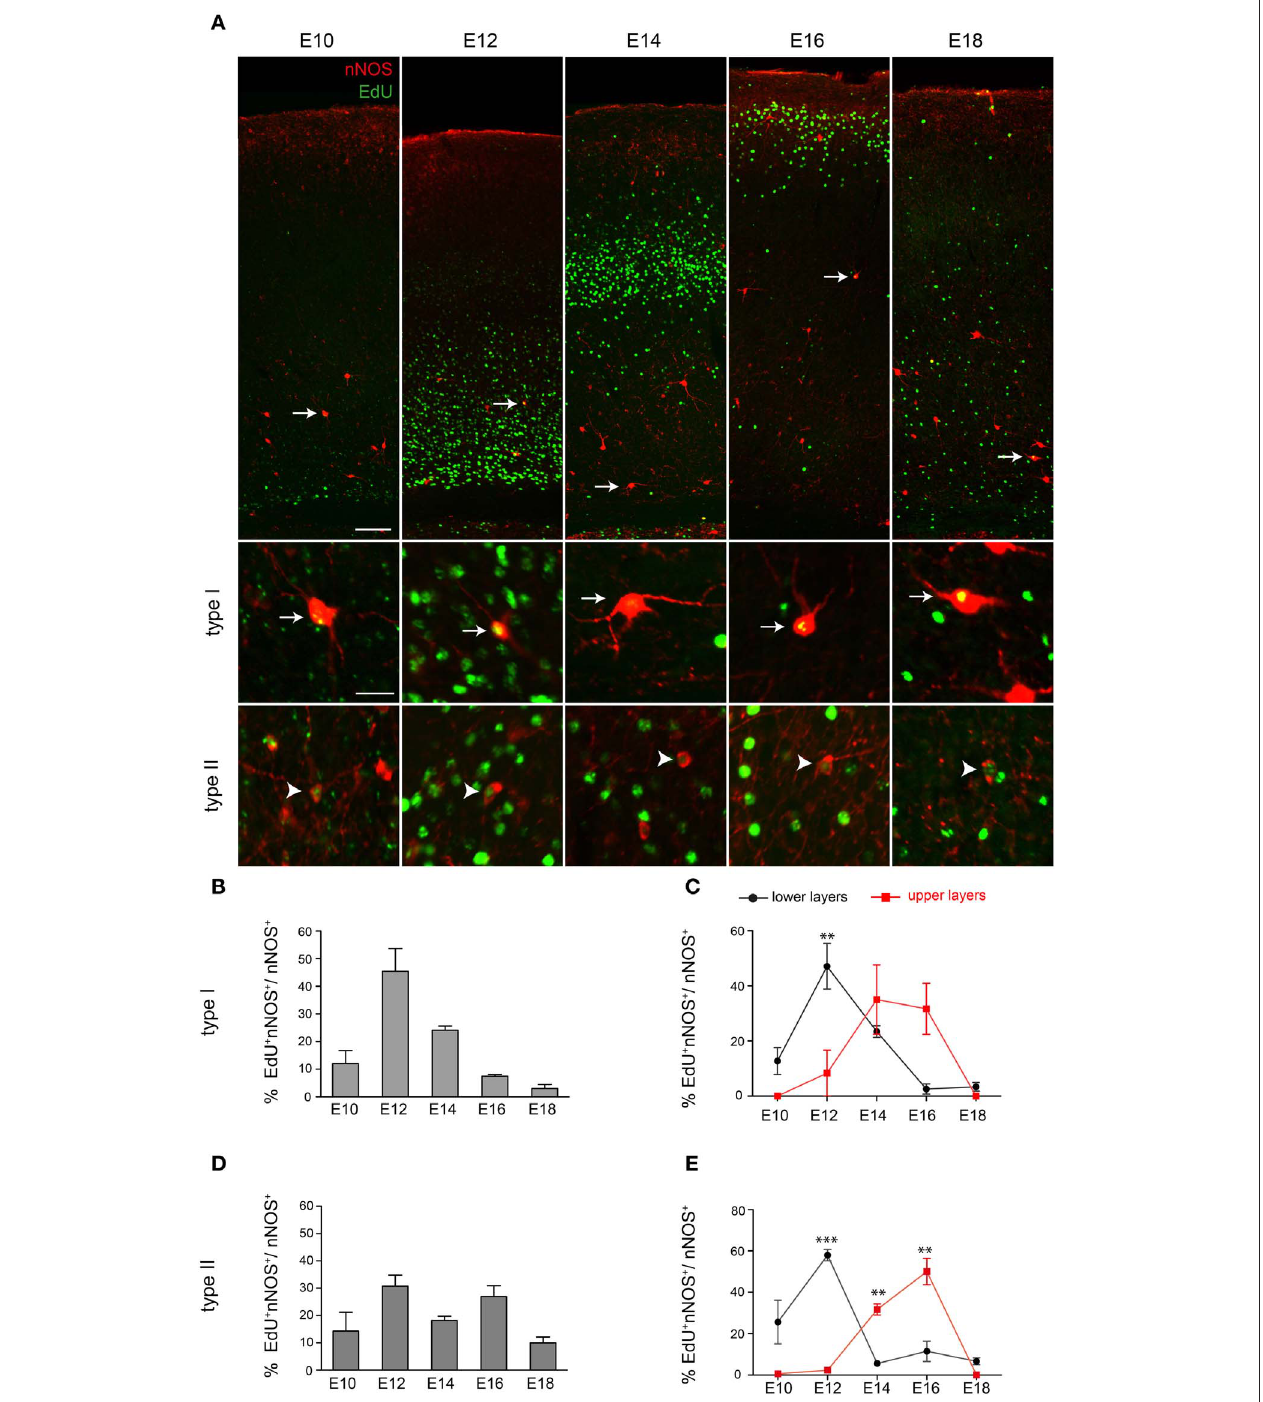
FIGURE 2 | Neurogenesis period of cortical nNOS cells. (A) nNOS-positive neurons and EdU-incorporating cells at P30 following EdU administration at different developmental stages. White arrows and arrowheads indicate nNOS-immunoreactive neurons colabeled with EdU. These are shown at higher magnification in the lower panel for type I (arrows) and type II cells (arrowheads). (B) Histogram showing the EdU labeling index for nNOS type I cells. (C) Neurogenesis periods of nNOS type I cells residing in lower and